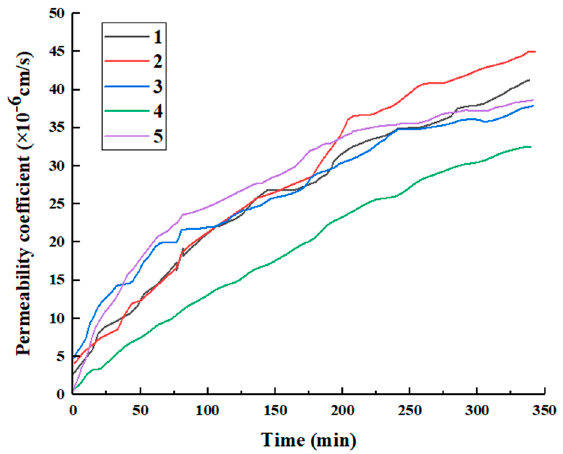
Figure 5. Curve of permeability test results of paste fi lling body.